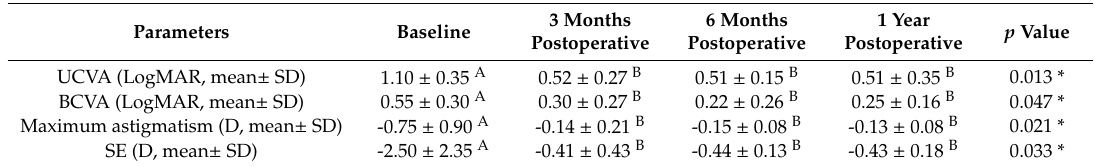
Table 3. The change in visual acuity and refractive status in the enhancement group after the topography-guided laser in situ keratomileusis.